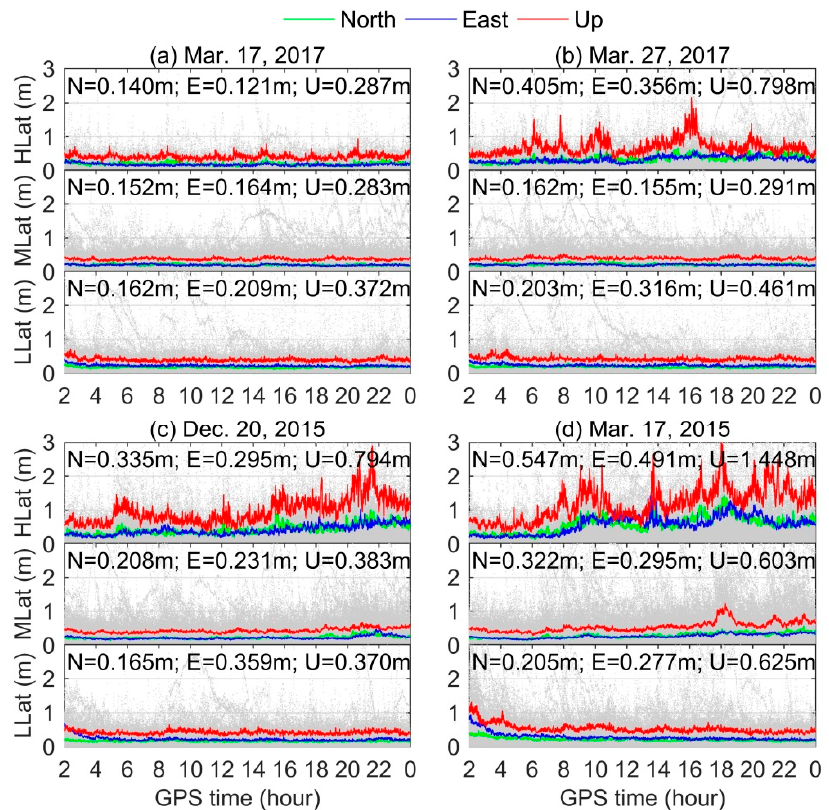
Figure 9. The 90% confidence level of time series of SF PPP results for all stations located at high-, mid-, and low-latitude regions on: ( a ) 17 March 2017 as the quiet day reference; ( b ) 27 March 2017 as the moderate storm; ( c ) 20 December 2015 as the intense storm; and ( d ) 17 March 2015 as the super storm, respectively. The background gray scatters are the absolute values of positioning results for each IGS station.